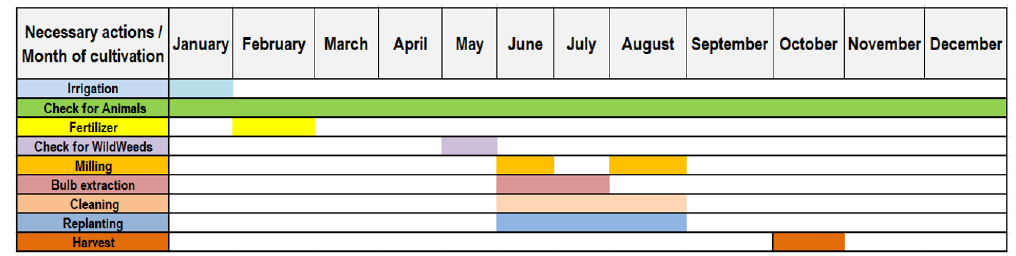
Figure 3. Saffron cultivation yearly